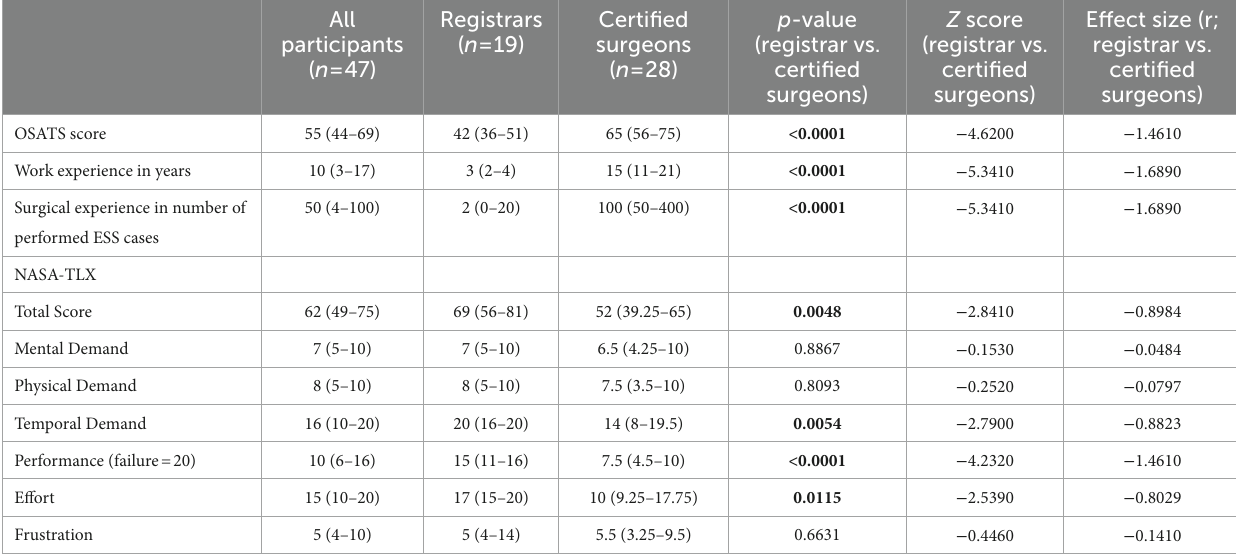
TABLE 1 Characteristics of participants in the present study.